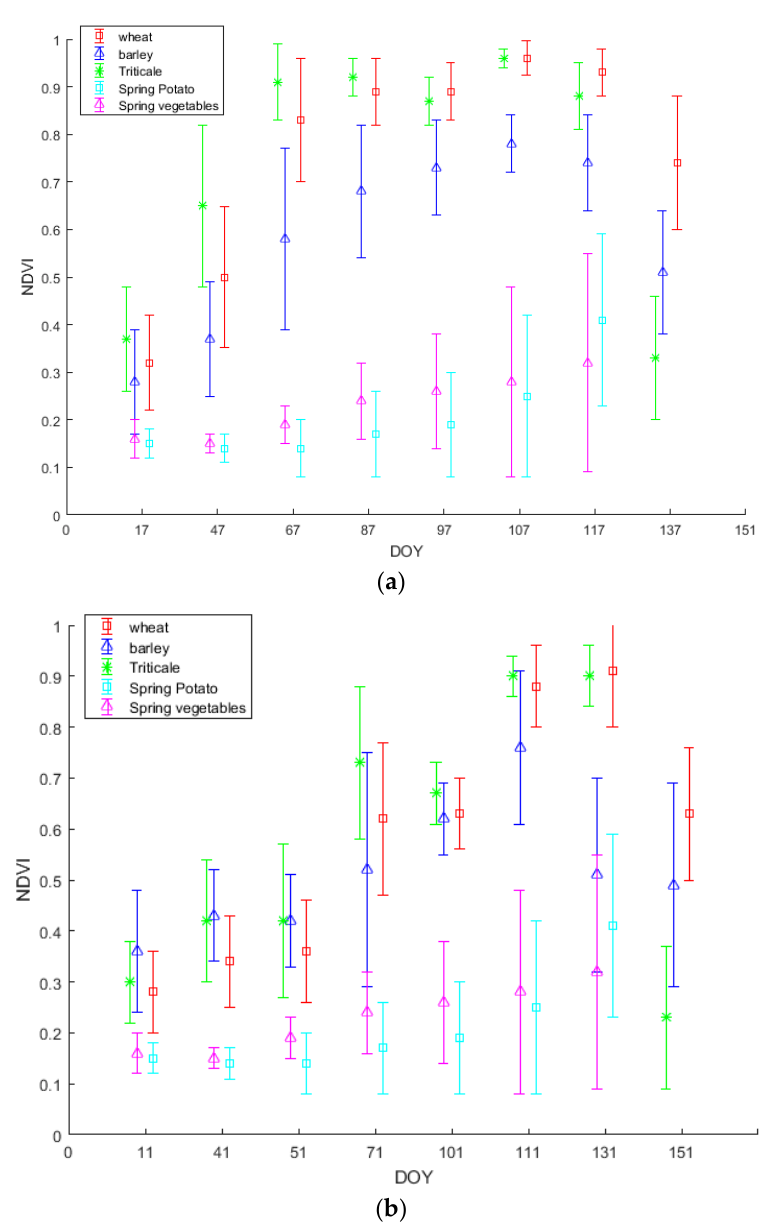
Figure 7. NDVI temporal profile of wheat, barley, triticale, spring potato and spring vegetables of 2016 ( a ) and 2017 ( b ) years.